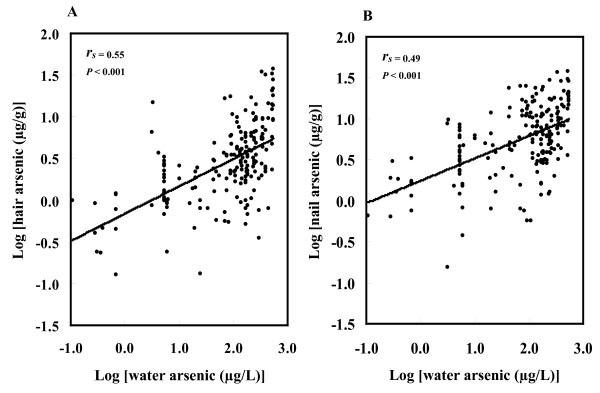
Relationship between drinking water, hair and nail arsenic concentrations. Relationship between drinking water arsenic and the arsenic in hair (A) or in nails (B) of the study subjects. Arsenic concentrations in the water, hair and nails were used after log transformation. rs and p- values were from Spearman correlation coefficient test.